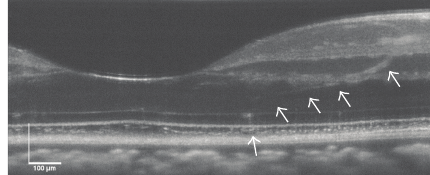
Figure 7: Damage response to picosecond exposure (331 mJ/cm 2 ) 1 hour following exposure. Scale bar: 100 𝜇